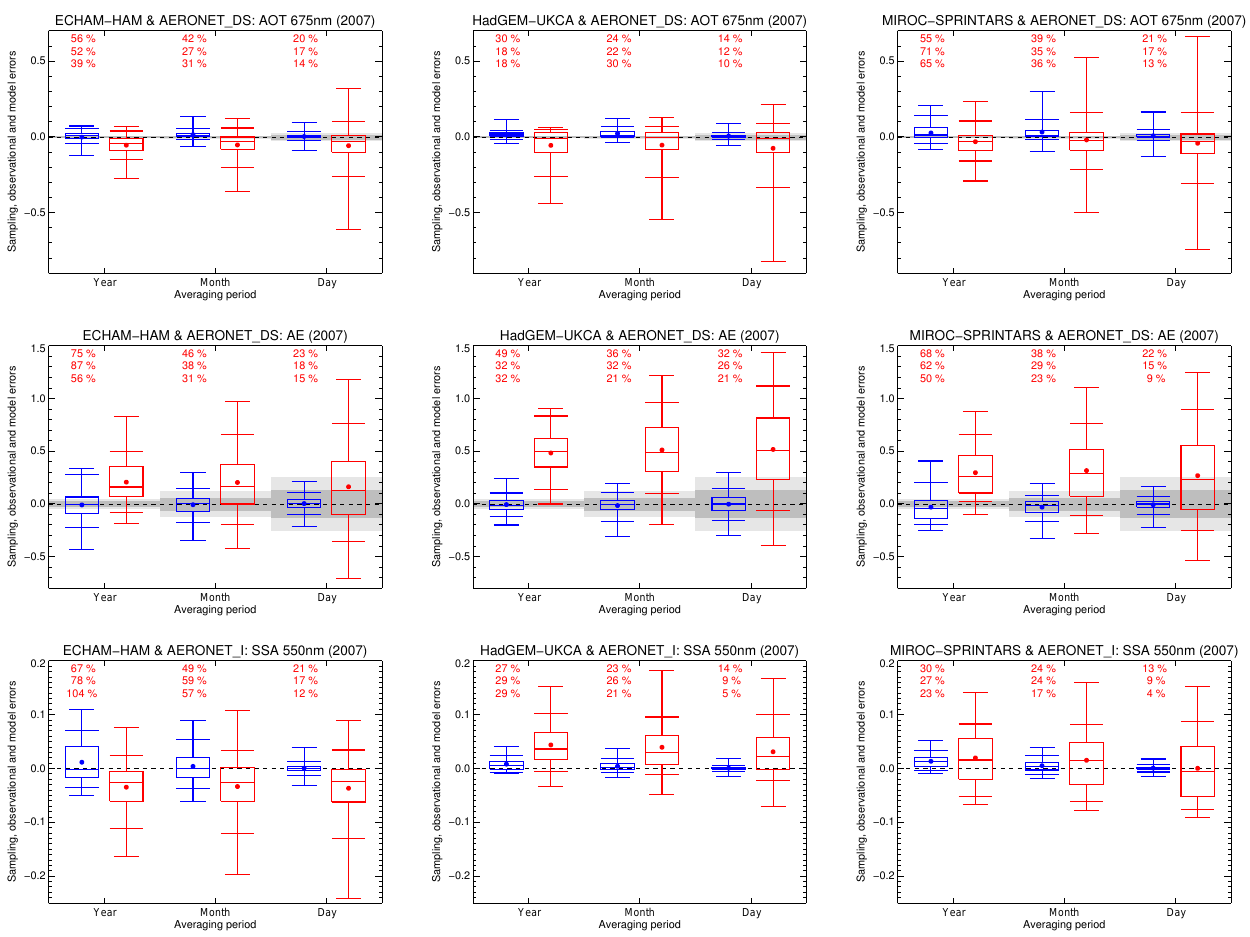
Figure 16. Box-whisker plots of temporal sampling errors, observational and model errors. For AERONET, sampling errors (blue), observa- tional errors (grey) and model errors (red) are shown side by side as a function of averaging period (yearly, monthly, daily). The box-whisker plot shows the 2, 9, 25, 50, 75, 91 and 98% quantiles of these errors, the dot shows the mean error. The grey shading shows the 9, 25, 75 and 91% quantiles of the observational errors. The red numbers above each blue box-whisker show how the different quantile ranges (from top to bottom: 2–98, 9–91 and 25–75%) compare between the sampling error and the model errors. For SSA, no observational error estimates were